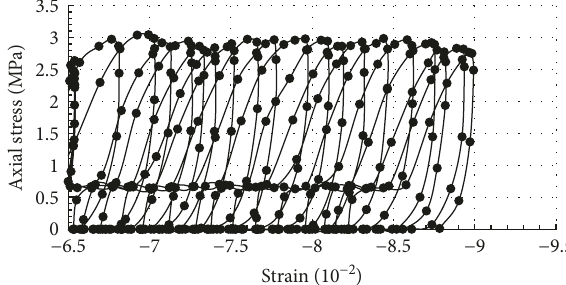
0.5 MPa, and A (cid:31)